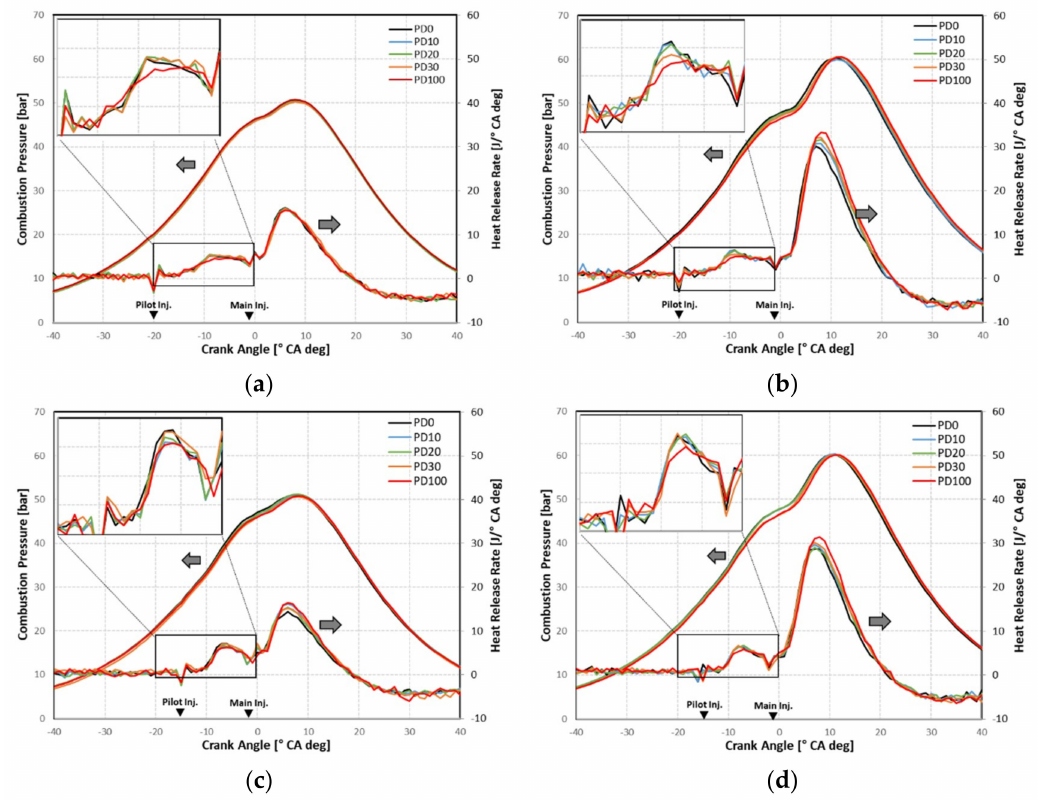
Figure 3. Combustion pressure and heat release rate. ( a ) Engine load 0 Nm and pilot BTDC 20 ◦ CA, ( b ) engine load 40 Nm and pilot BTDC 20 ◦ CA, ( c ) engine load 0 Nm and pilot BTDC 15 ◦ CA, and ( d ) engine load 40 Nm and pilot BTDC 15 ◦